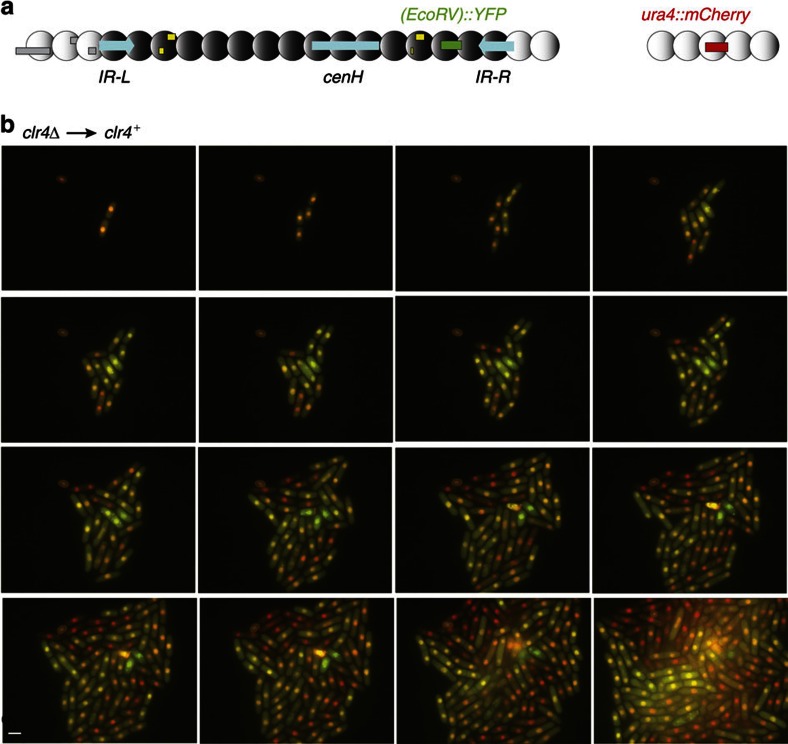
Fission yeast cells dividing under a fluorescence microscope establish gene silencing.(a) Fluorescent reporters used for imaging. (b) Overlay of the mCherry and YFP channels, starting at the first cell division following the re-introduction of clr4+ through a cross. At first, cells express both YFP and mCherry (yellow-green signal). As they divide, a few cells silence YFP (red signal). The silenced state is inherited clonally in their progeny. Scale bar, 5 μm. Additional timepoints and separate channels are shown in Supplementary Movies 1-3.